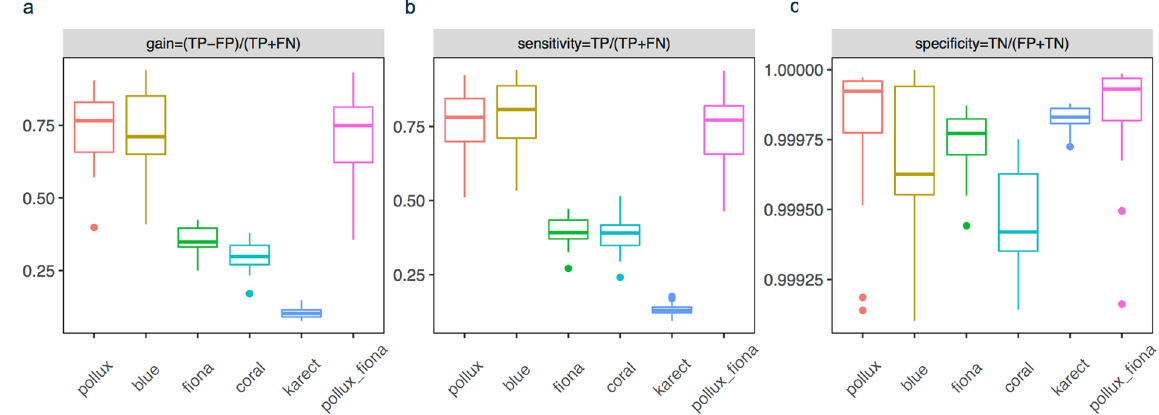
Figure 2. Comparison of the error correction algorithms using 19 empirical data sets sequenced in the HBV RT region with respect to the measure of gain ( a ), sensitivity ( b ), and specificity ( c